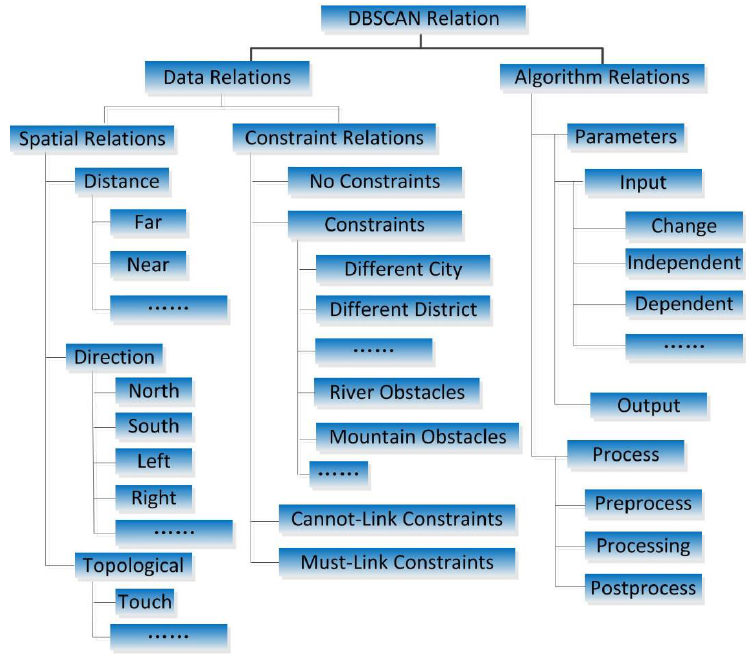
Figure 9. Structural classification of geospatial relations.